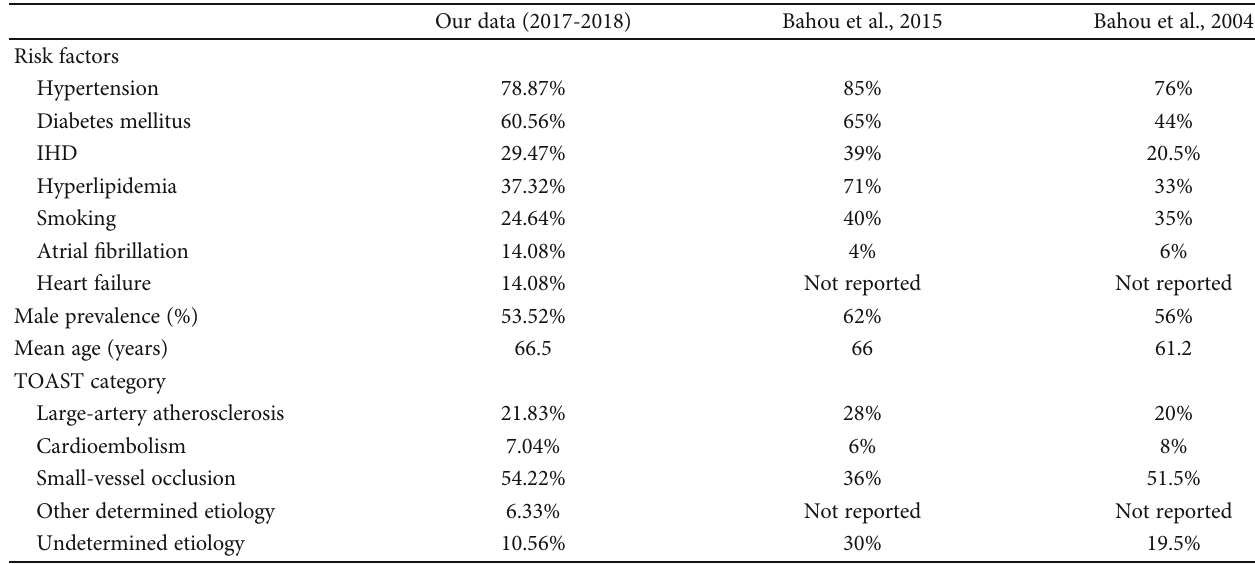
Table 9: Prevalence of risk factors, mean age, male prevalence, and stroke categories in 3 local studies from